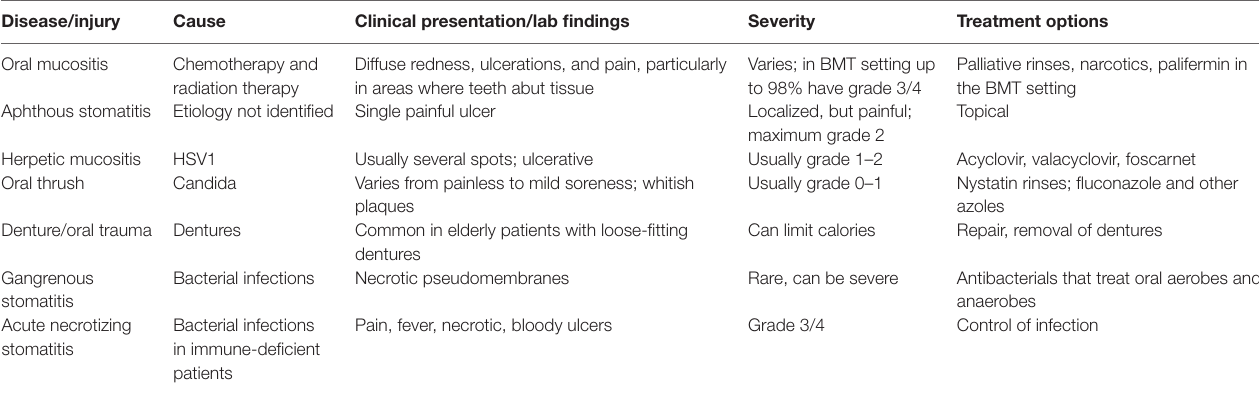
TAbLe 7 | Differential diagnosis of RiOM (20,